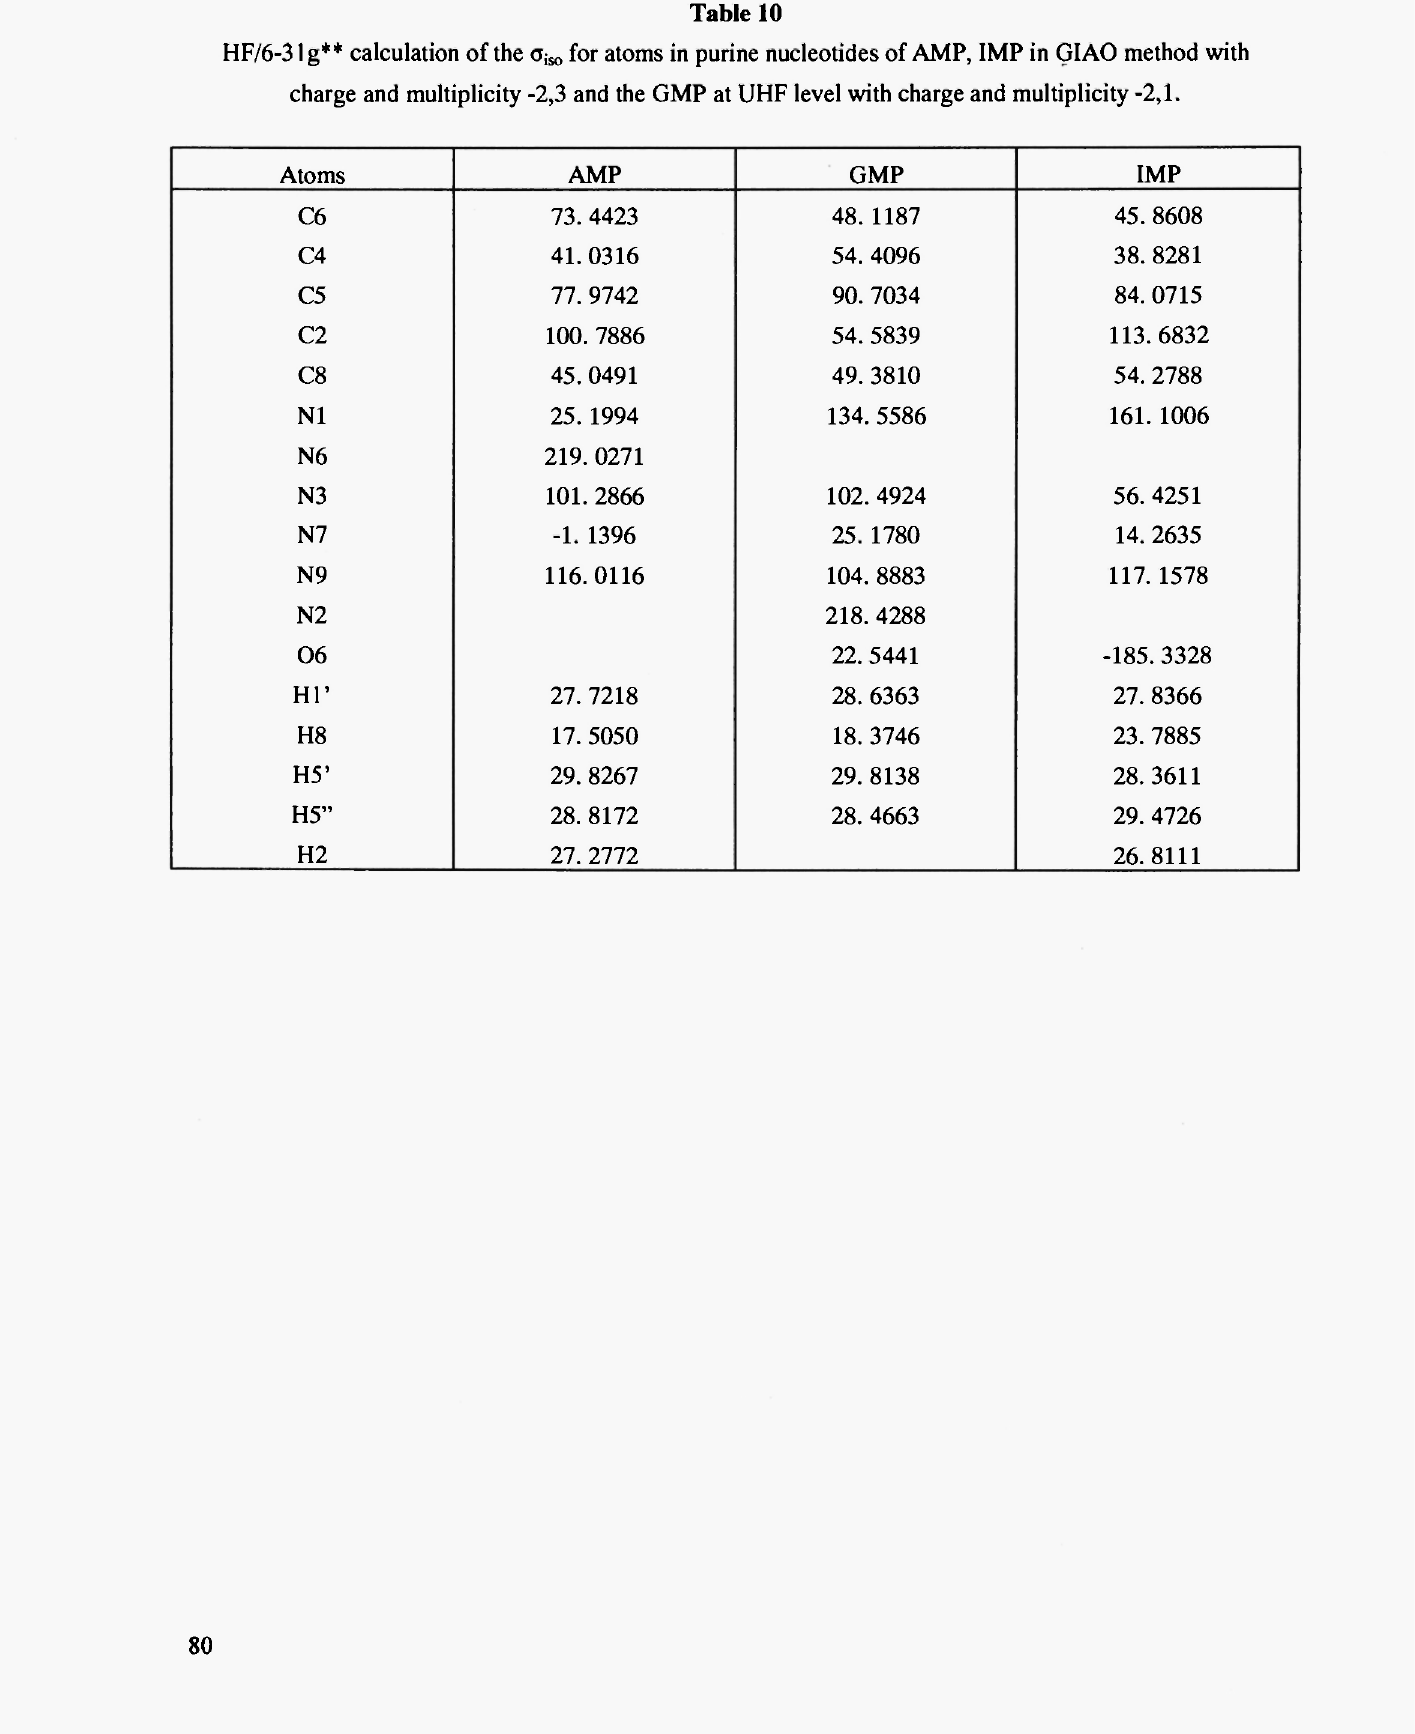
HF/6-31 g** calculation of the o iso for atoms in purine nucleotides of AMP, IMP in GIAO method with charge and multiplicity -2,3 and the GMP at UHF level with charge and multiplicity